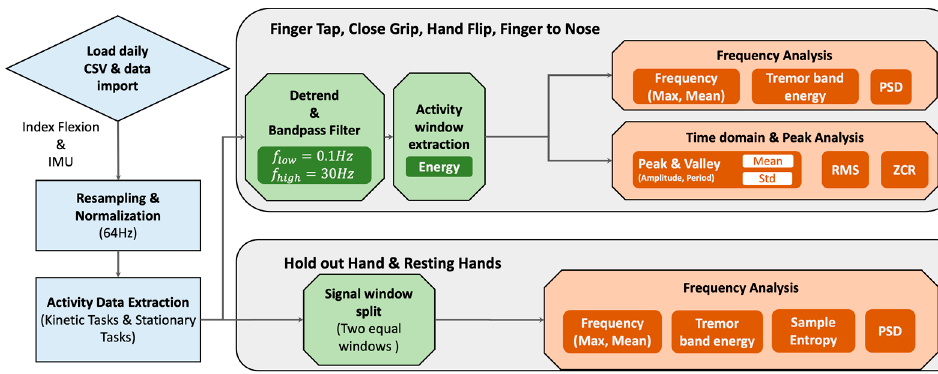
Figure 7. Signal processing pipeline used with iTex gloves.